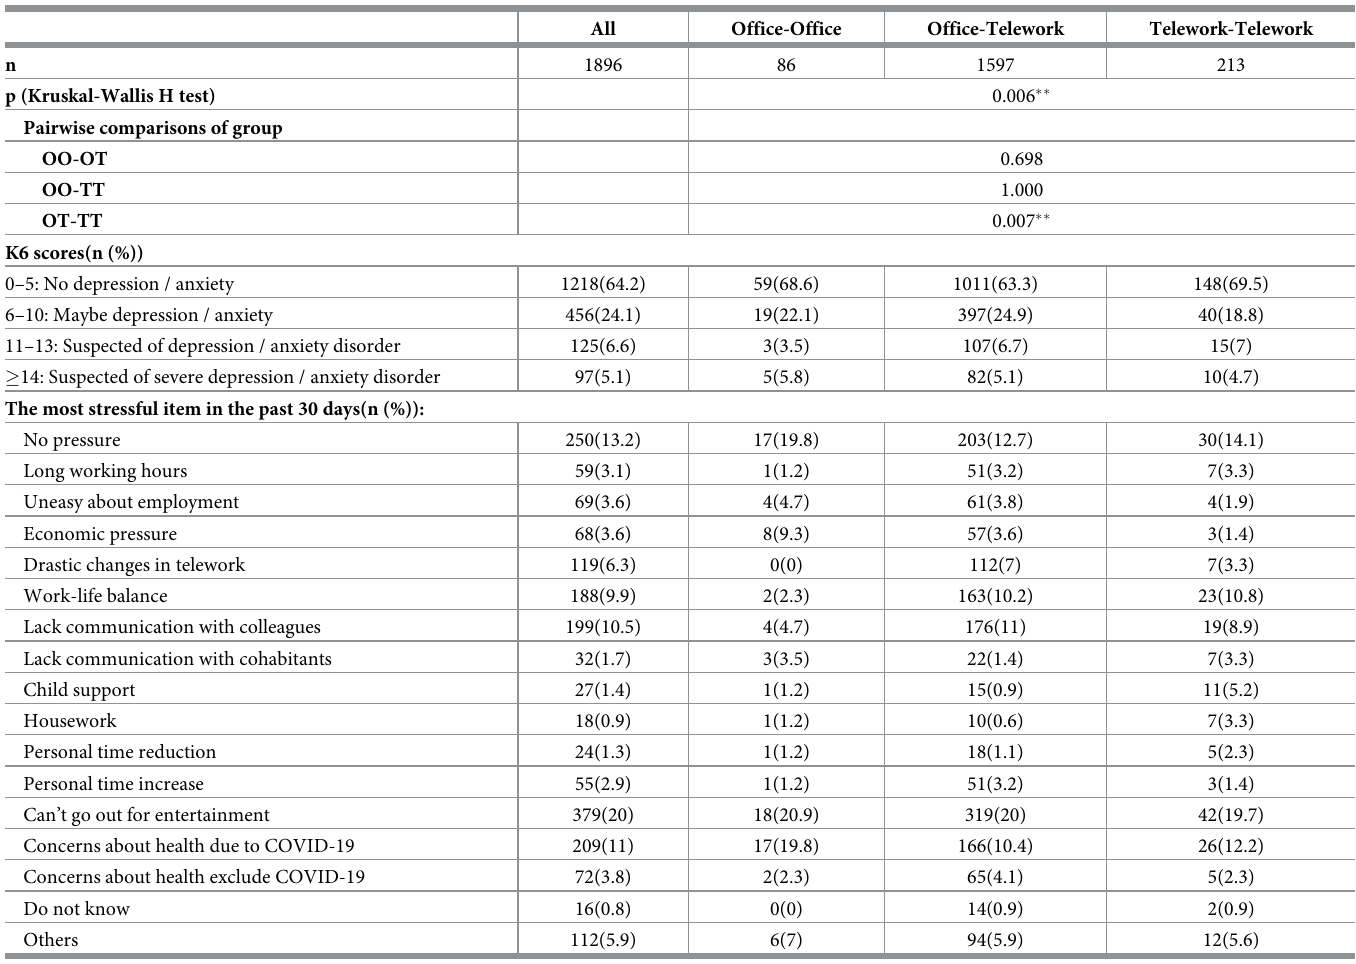
Table 4. Mental health after the emergency statement with K6 scale 1